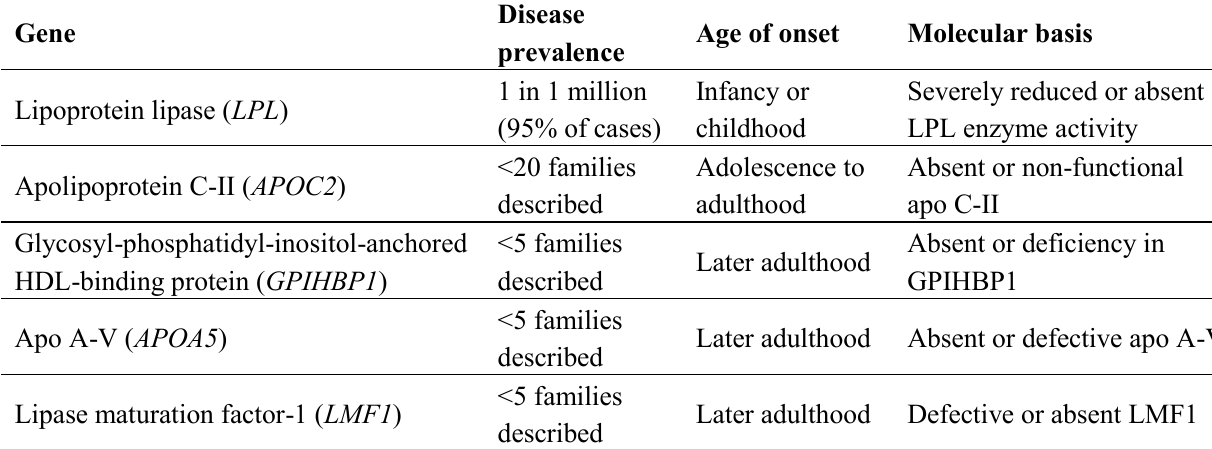
Abbreviations: as in Tables 1 and